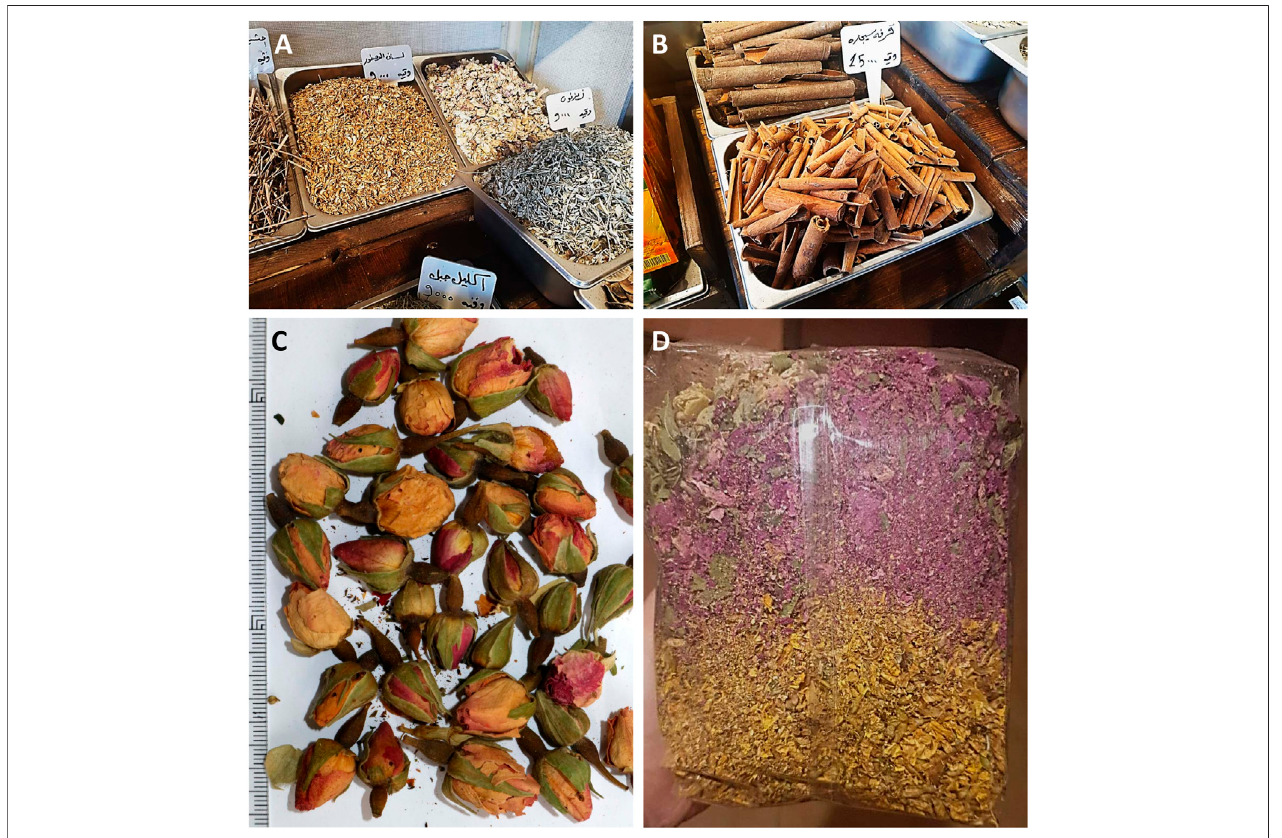
FIGURE 2 | Manufacture of traditional “ zhourat ” in Beirut. (A) boxes with herbal ingredients used in the “ zhourat ” blend; (B) cinnamon ( Cinnamomum verum ) is amongthespicesoccasionallyusedin “ zhourat ” blends; (C) Rosadamascena fl owerbuds; (D) “ zhourat ” bagfromtheBeirutherbalstoreshowingtheroleof fl owersasa source of color. Photos: (A) , (B) , (D) , L. Attieh; (C) , D. Rivera.